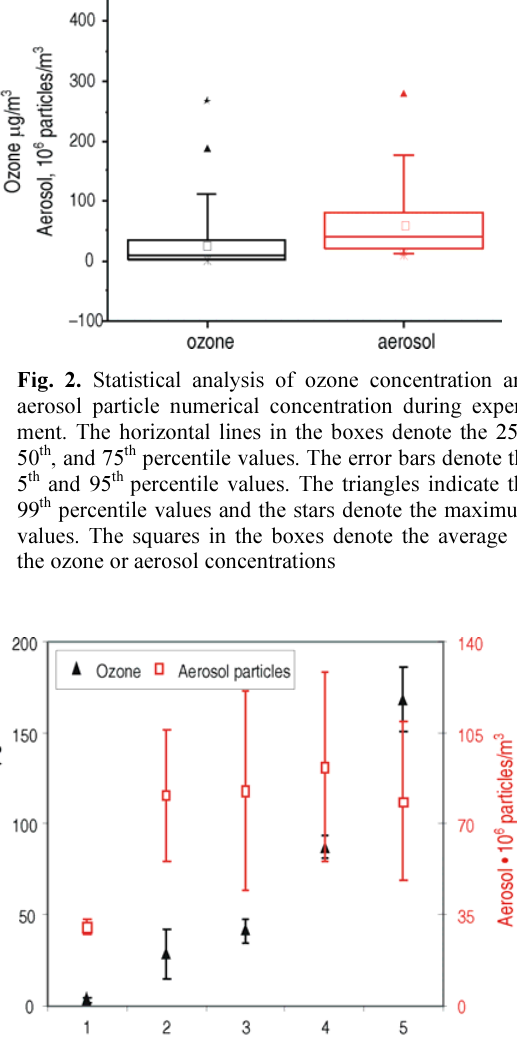
Fig. 3. Change of ozone and aerosol particle numerical concentration with increase of copying intensity